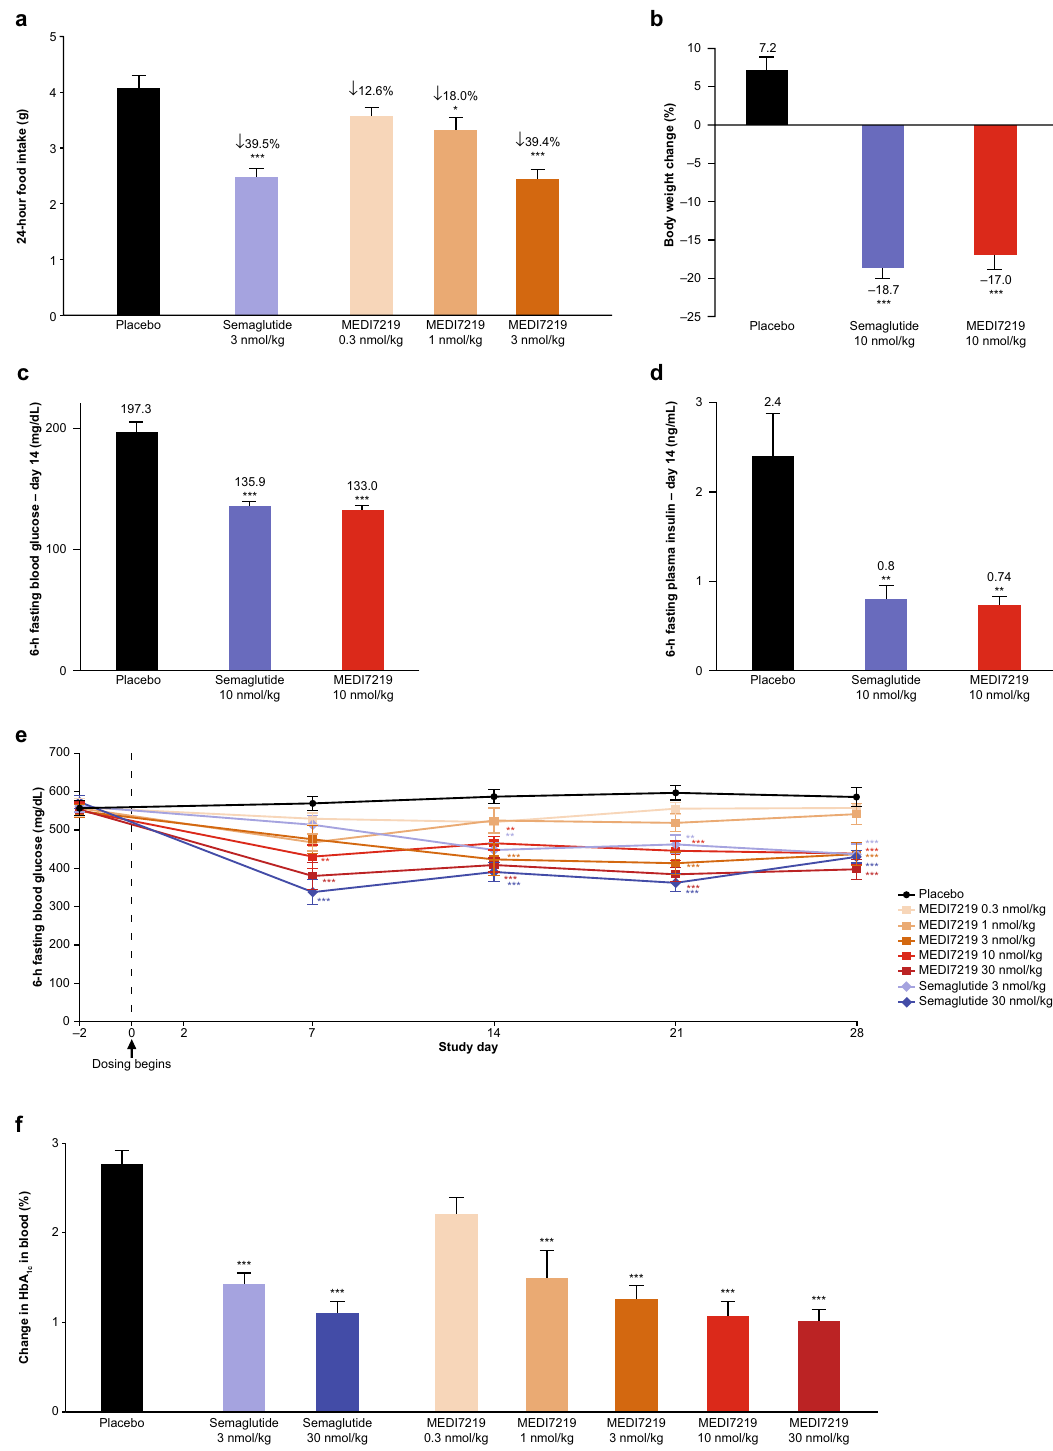
Figure 3. In vivo evaluation of GLP-1RAs. ( a ) Effect of subcutaneously administered MEDI7219 compared with semaglutide and placebo on food intake in the C57Bl/6 J mouse model (n = 6–9 per group). ( b ) Body weight change, ( c ) 6 h fasting glucose (day 14) and ( d ) 6 h fasting insulin levels (day 14) in DIO mouse model after repeated subcutaneous administration of MEDI7219, semaglutide or placebo over 21 days (n = 12 per group). ( e ) Blood glucose levels over 28 days in dose–response study in db/db mice treated with MEDI7219, semaglutide or placebo (n = 9 per group). ( f ) Change in %HbA 1C levels in 28-day dose–response study in db/db mice treated with MEDI7219, semaglutide or placebo (n = 9 per group). * P < 0.05, ** P < 0.01, *** P < 0.001 versus placebo in all panels. Values are mean ± standard error of